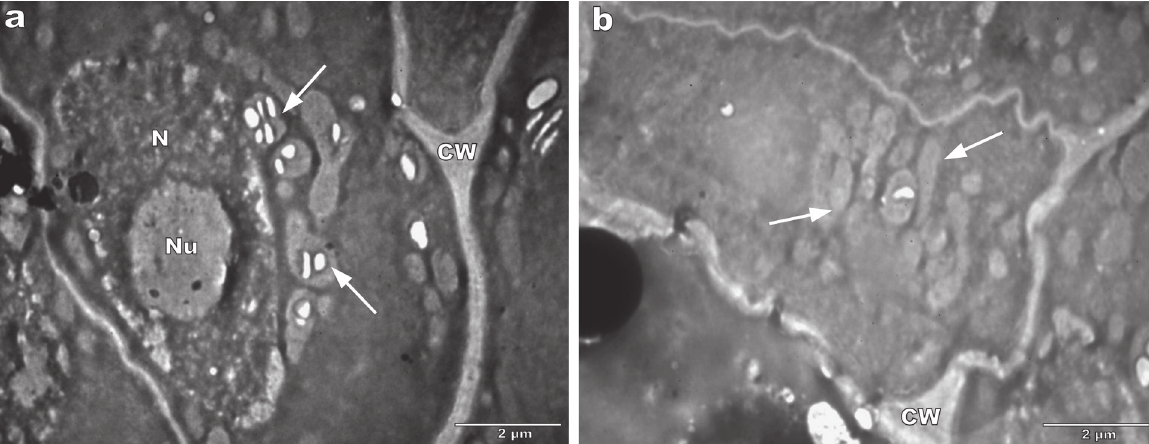
Figure 6 - Transmission electron micrographs of the callus Type 2. A) Large nuclei, prominent nucleoli and amyloplasts (arrow). B) Mitochondria (arrows), cell wall (CW), nucleus (N) and nucleolus (Nu).